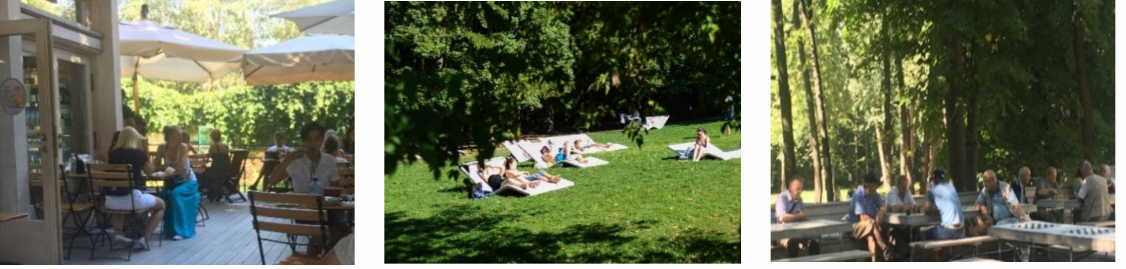
Figure 10. UGS for socializing (meeting other people) (Photos: D.